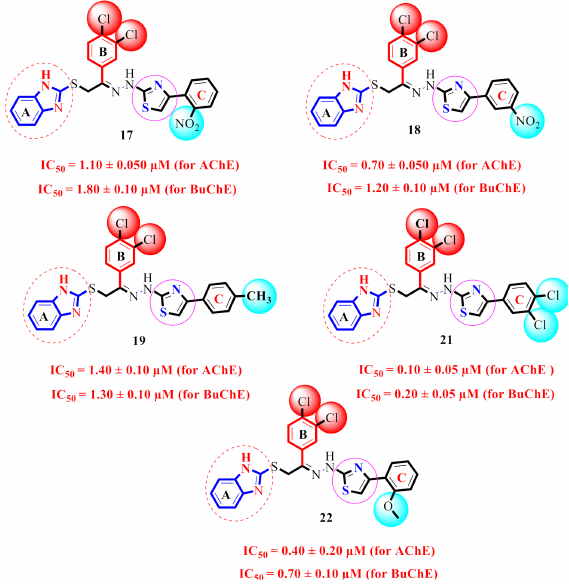
Figure 9. SAR study of scaffolds 17 , 18 , 19 , 21 and 22